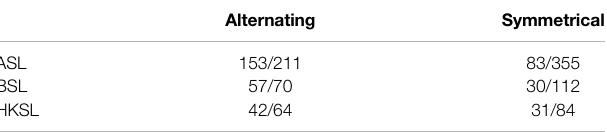
TABLE 2| Numberofrepeated tokensforalternatingand symmetrical signsinthe three sign languages. Alternating Symmetrical ASL